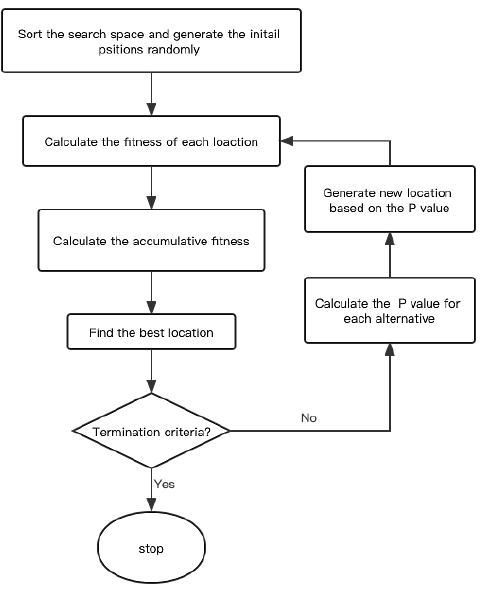
Figure 4. The flowchart of the DE